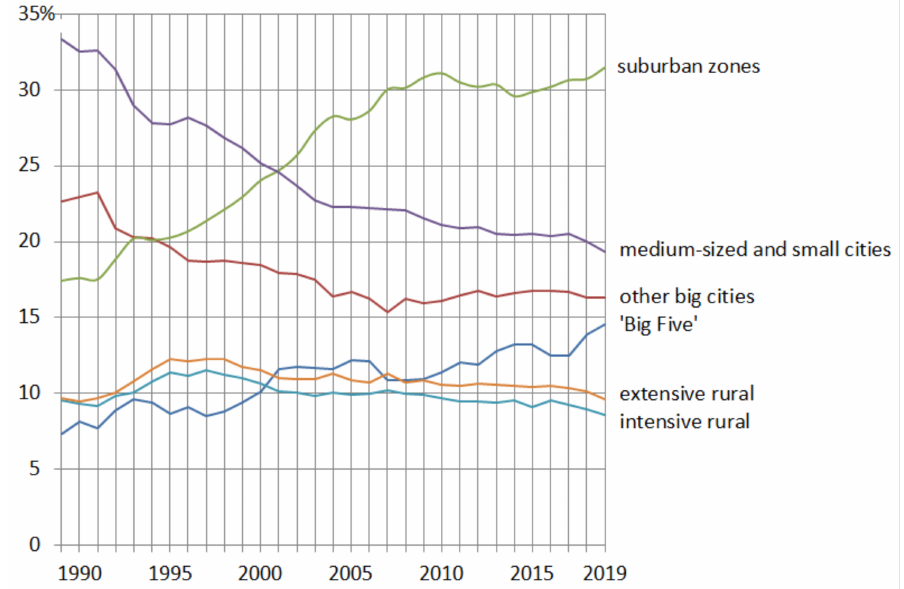
Figure 1. Share in registered inflows in Poland in 1989–2019 of different types of areas (communes). Source: based on migration matrices of Statistics